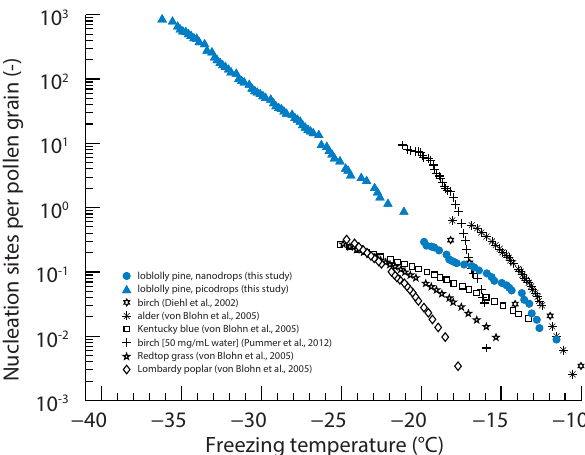
Figure 6. Number of nucleation sites per pollen grain as a function of temperature for various pollen types. Data from this study are shaded in blue. All other data were obtained from Fig. 15 of Murray et al. (2012). References to the original source are provided in the